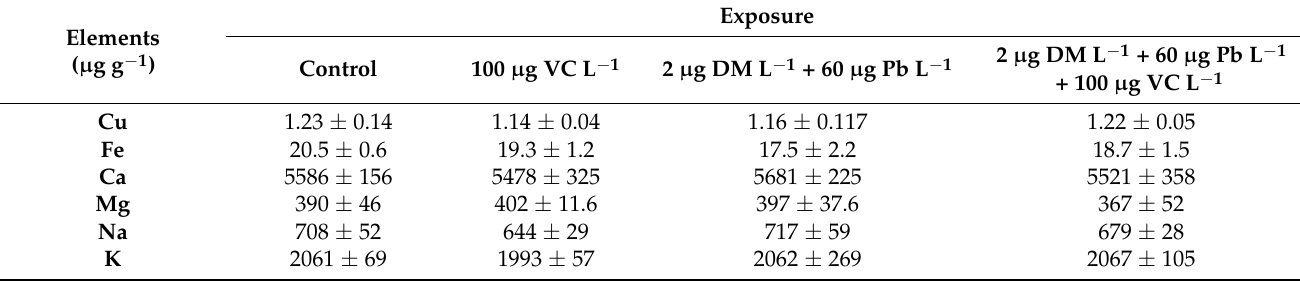
The results for the fish muscle reference material that was prepared and analyzed were: Na (certified 2.8 g kg − 1 and obtained 2.65 ± 1.3 g kg − 1 ), K (certified 21.8 g kg − 1 and obtained 21.1 ± 0.65g kg − 1 ), Ca (certified 0.342 g kg − 1 and obtained 0.343 ± 0.002 g kg − 1